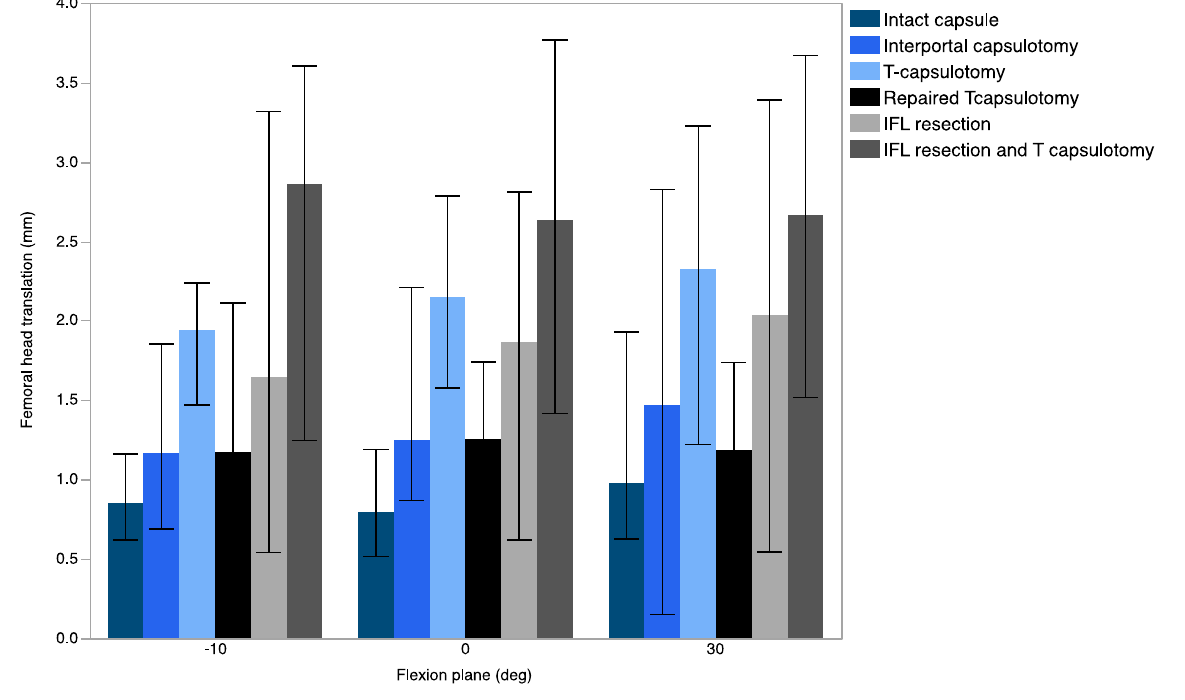
Figure 6. Translation measured as a change in femoral head center of rotation in − 10 ◦ , 0 ◦ , and 30 ◦ flexion.